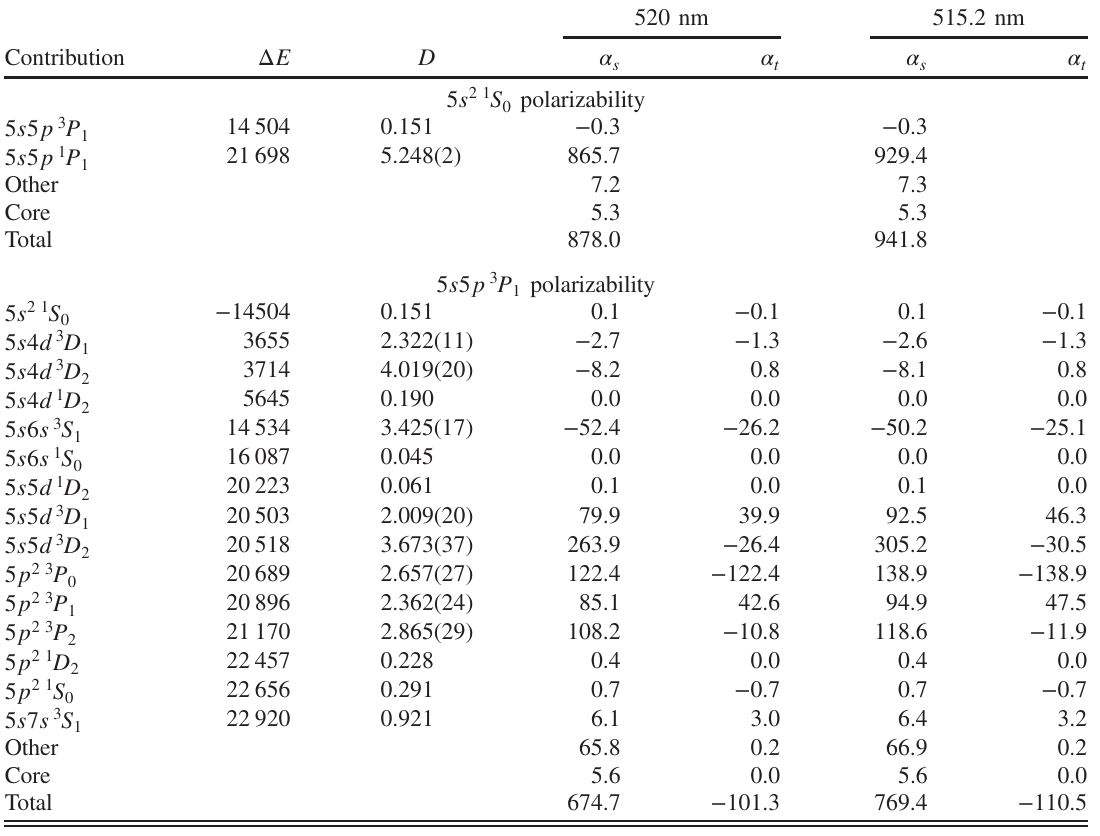
and tensor α polarizabilities for the 5 s 2 1 S 0 and 5 s 5 p 3 P 1 states at s t